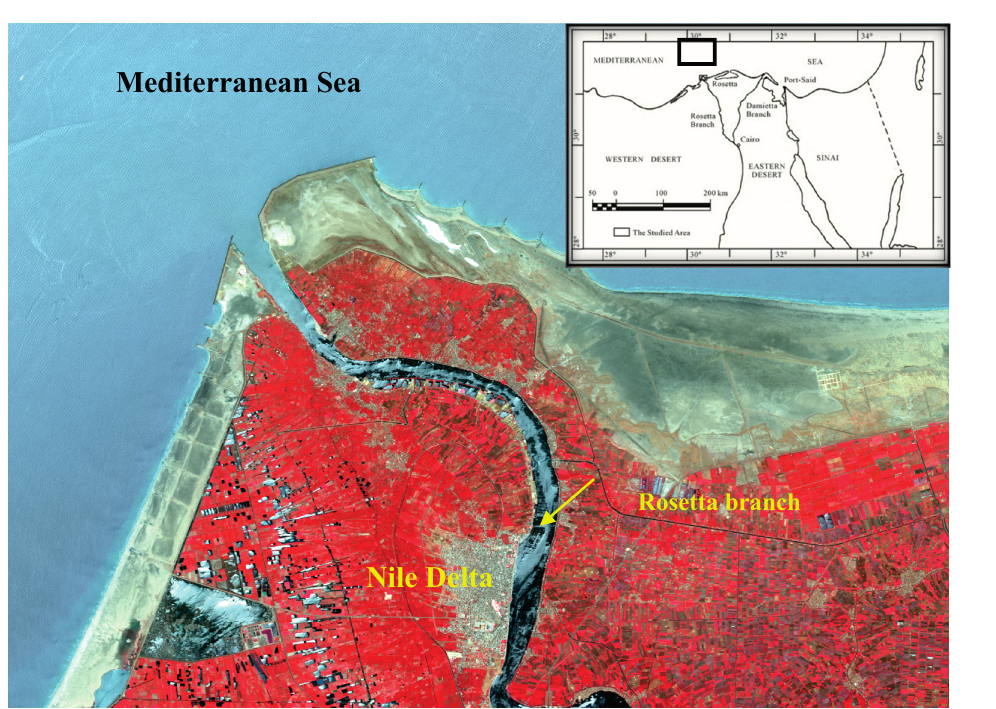
Figure 1. Study area, Rosetta Promontory at the terminal of Rosetta branch, SPOT image, 2012.